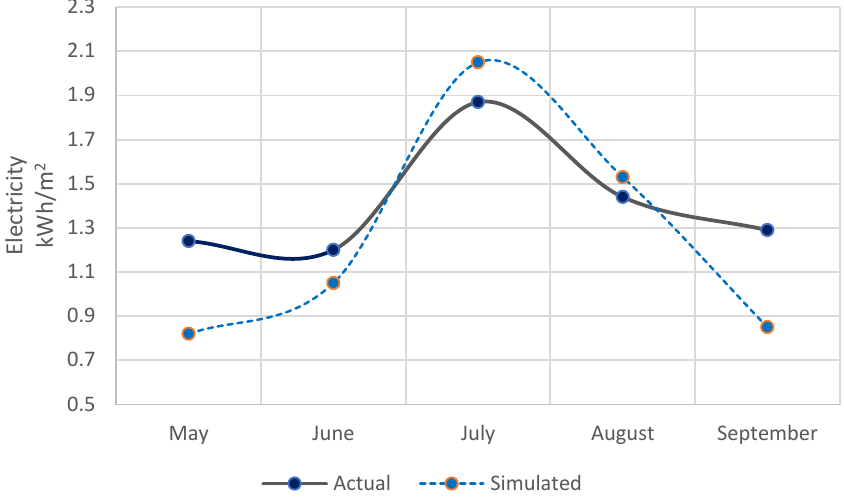
Figure 11. Validation of actual and simulated electricity demand for ventilation.